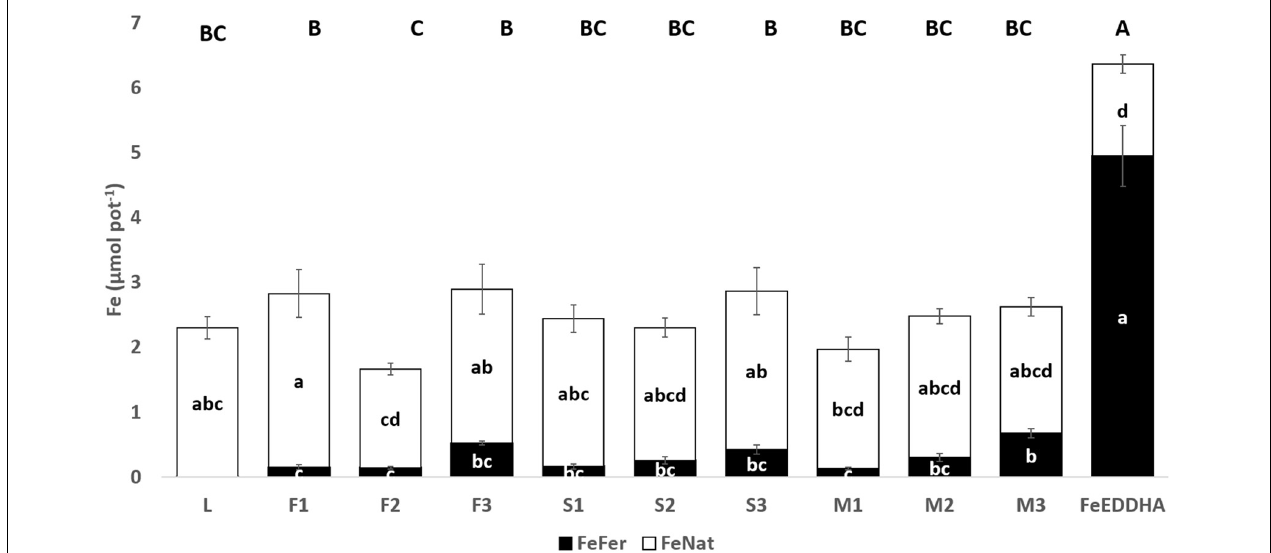
FIGURE 6 | Fe Fer and Fe Nat ( µ mol pot − 1 ) contents in soybean shoots of control plants (L) and plants fertilized with the 57 Fe products F, S, and M in three doses: (1) 35, (2) 75, and (3) 150 µ mol 57 Fe pot − 1 or 50 µ mol 57 FeEDDHA pot − 1 , calculated as the sum of the first (15 DAF) and second sampling (48 DAF). For each series different letters denote significant differences among the treatments according to Duncan’s Test ( p < 0.05). Lowercase letters correspond to Fe Fer and Fe Nat and capital letters correspond to Fe Total statistical results. Results are expressed as averages ± standard error, n = 5.